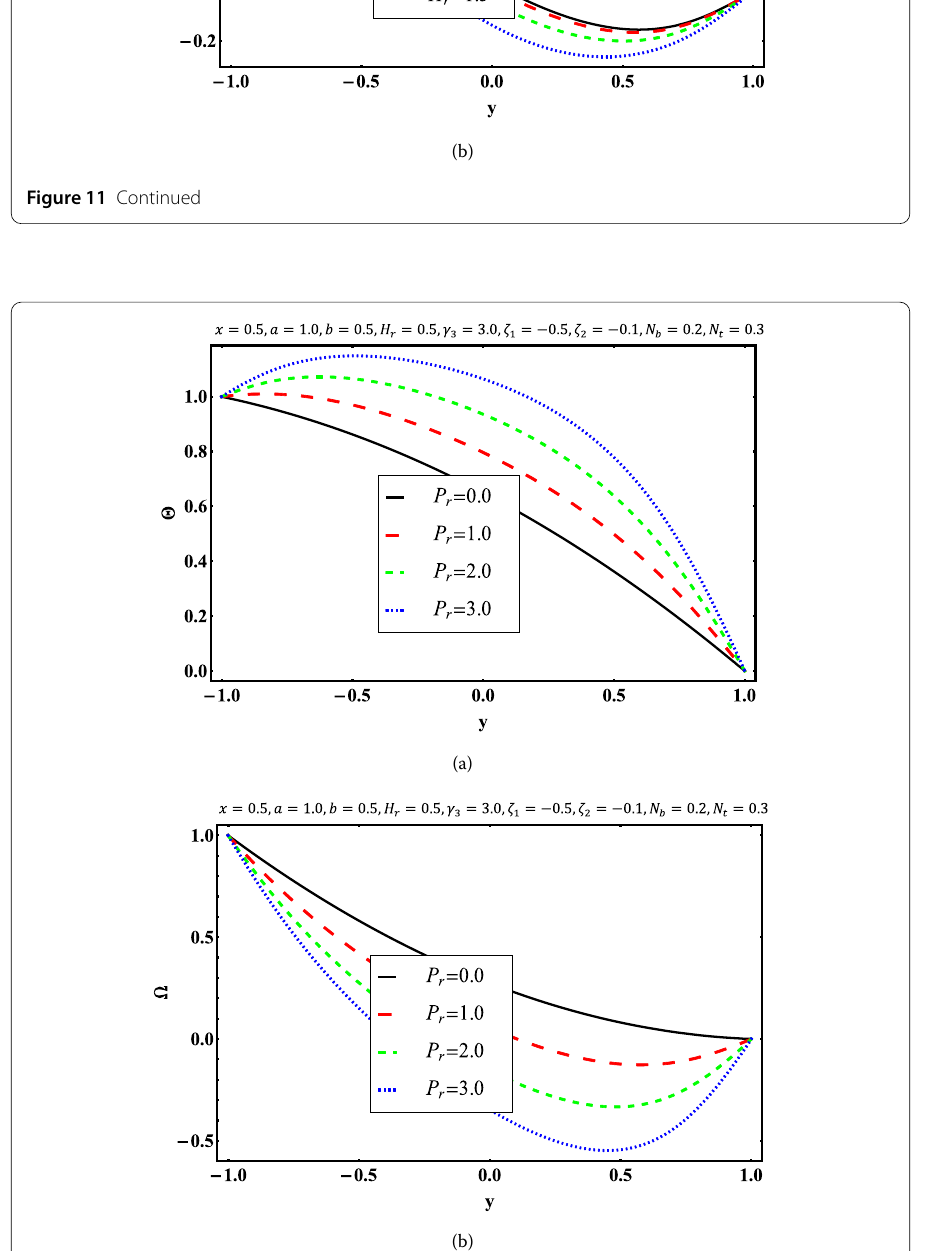
Figure 12 For different values of P r , ( a ) temperature distribution Θ and ( b ) concentration distribution Ω